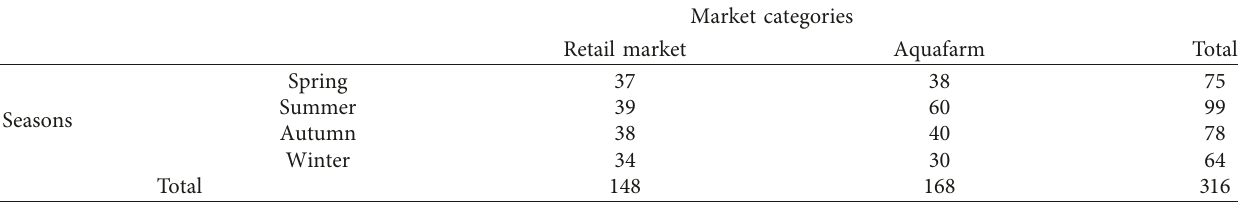
Table 1: Number of samples collected during June 2013 to March 2015.